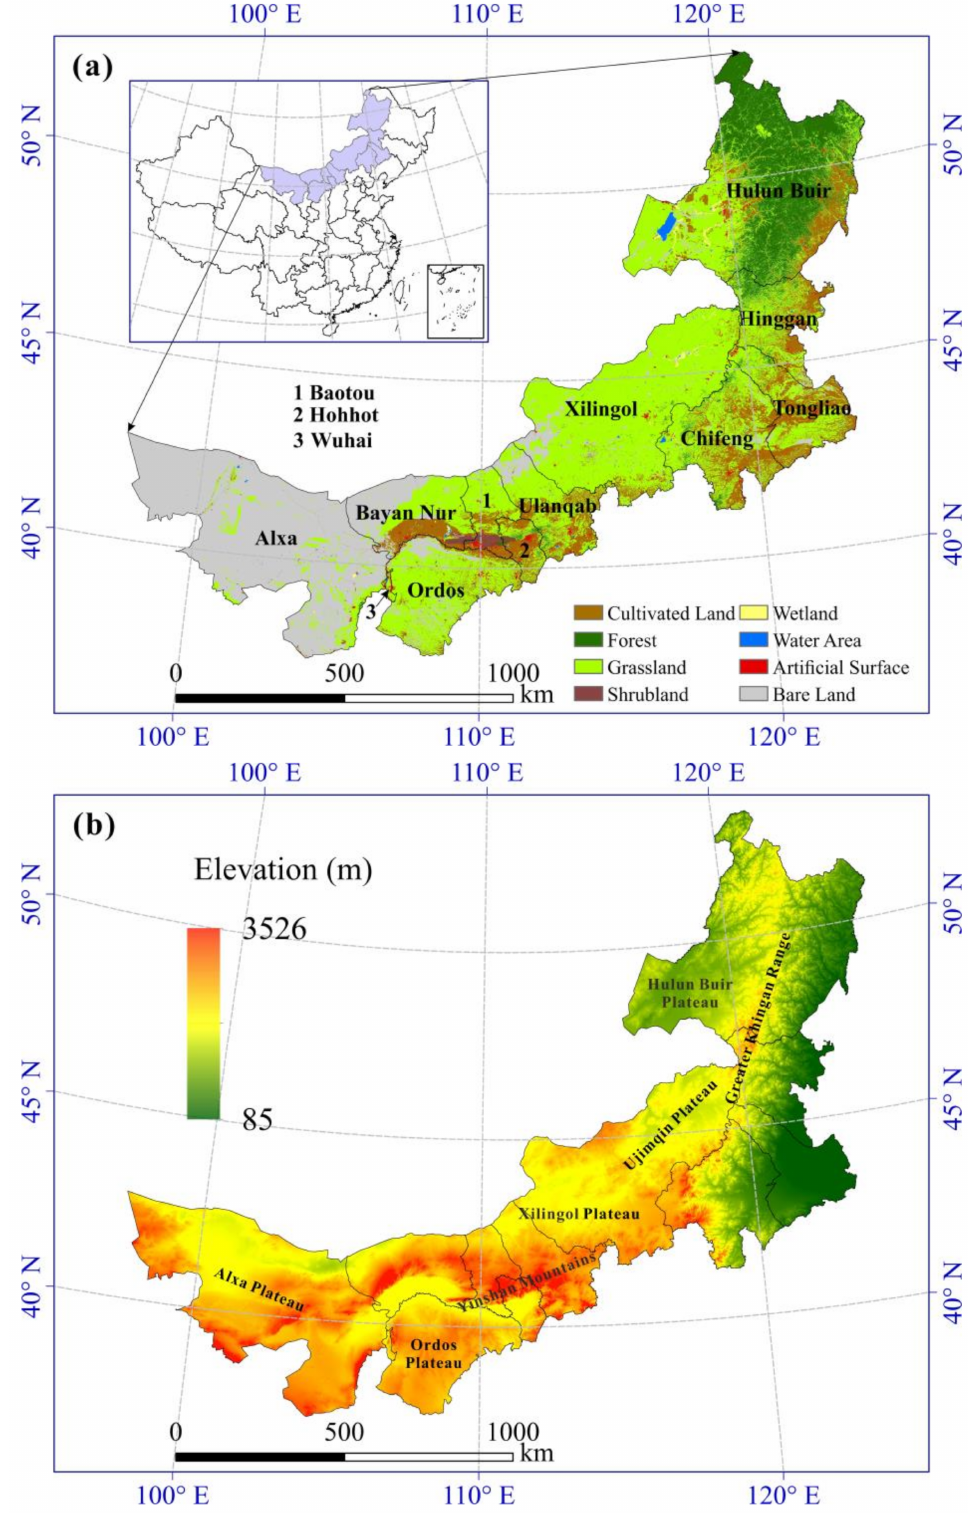
Figure 1. ( a ) Land cover and ( b ) digital elevation model of Inner Mongolia in